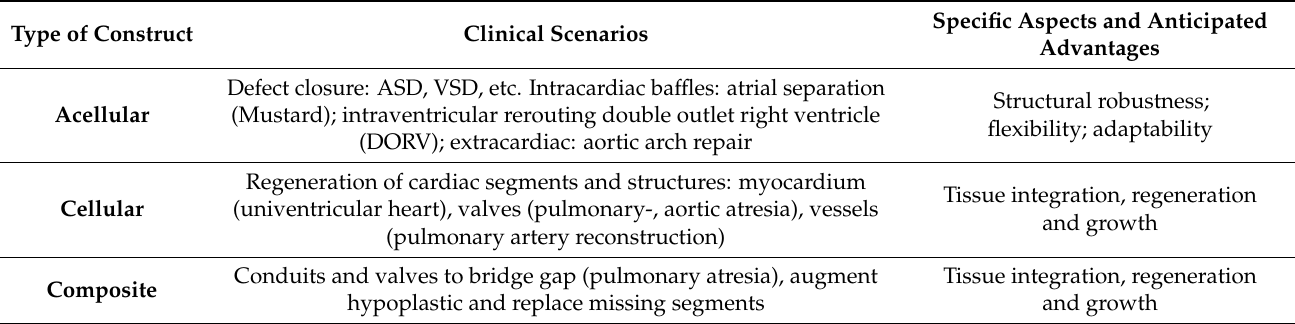
Specific Aspects and